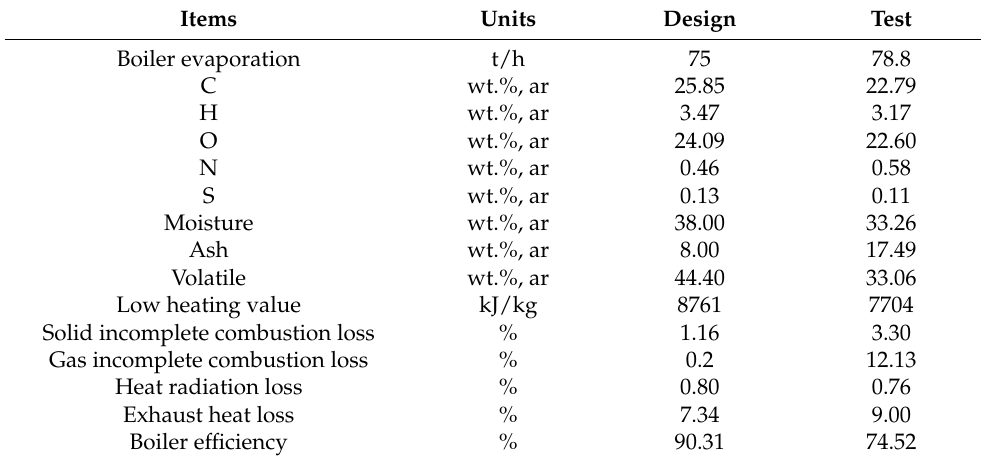
Table 2. Test results of the feeding fuel and boiler combustion